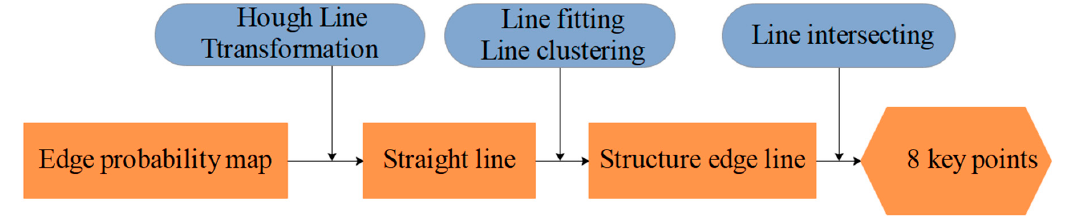
Figure 13. Edge probability map processing and key point extraction procedure.